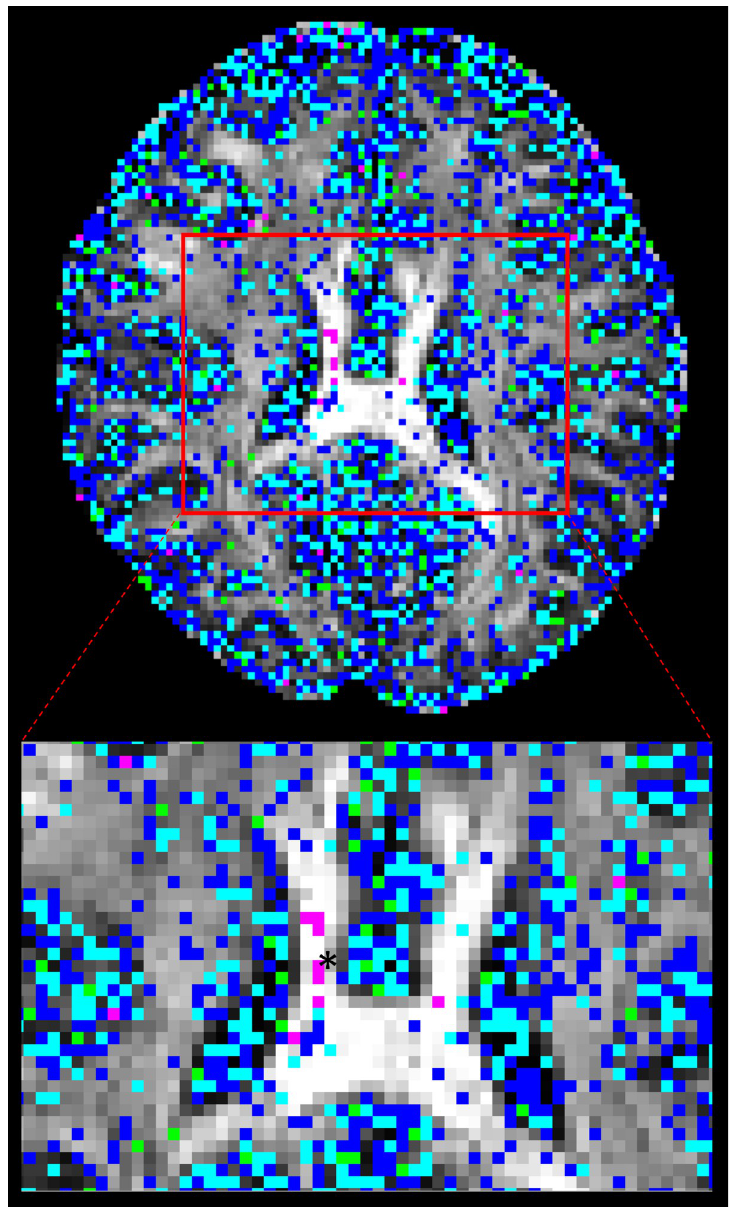
Fig 6. Significantly different ϕ 1 and θ 1 . Significantly different ϕ 1 and θ 1 distributions with S-ranges in 0.1–0.2 (Blue), 0.2–0.3 (light-blue), 0.3–0.4 (green), > 0.4 (magenta). Maximum S-score between ϕ 1 and θ 1 was used to categorize each location into different range (enlarged view from area in